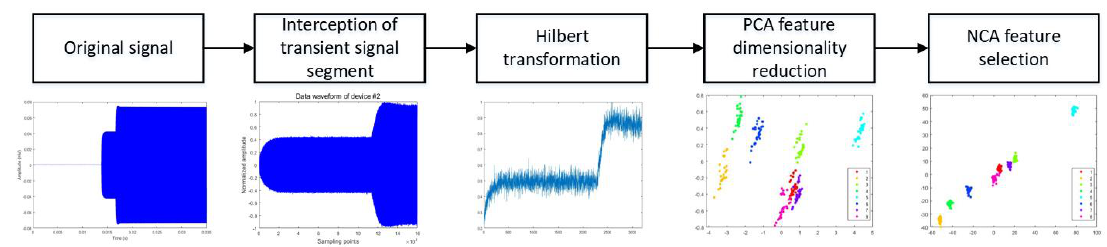
Figure 4. The radio frequency fingerprint (RFF) feature generation process. Neighborhood component analysis (NCA).